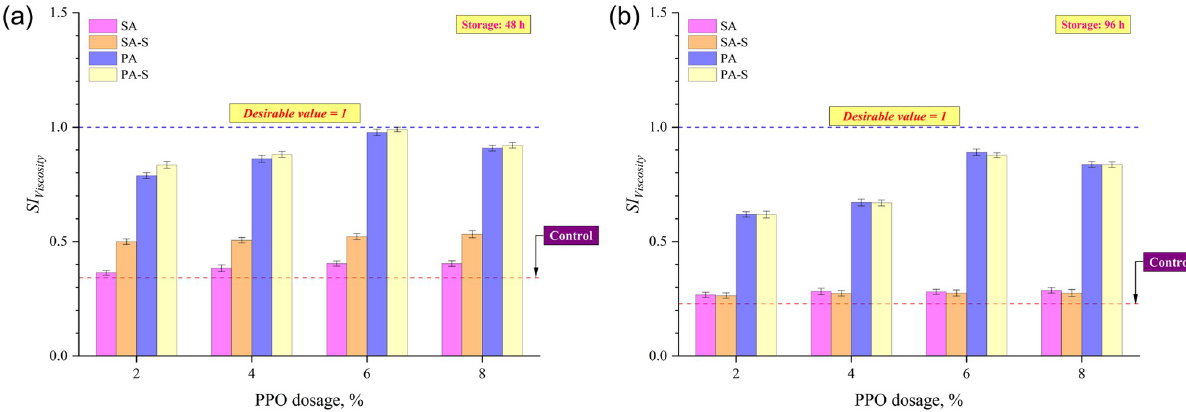
Fig 6. SI based on rotational viscosity after (a) 48 h and (b) 96 h of thermal storage.